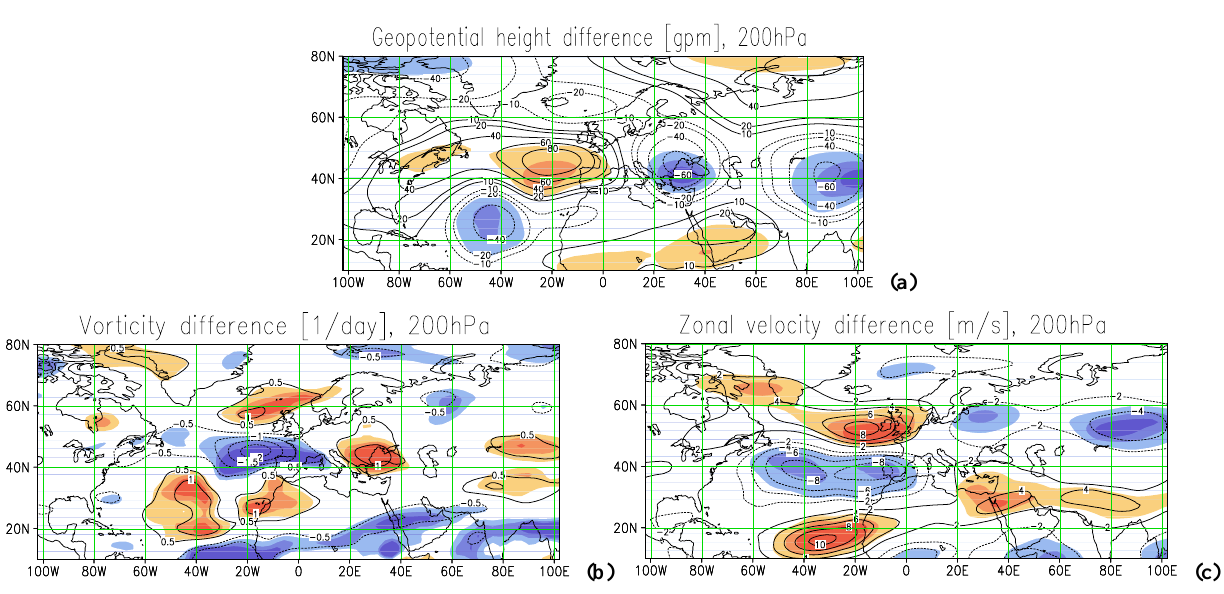
Fig. 5. Geopotential height, vorticity and zonal wind response at 200 hPa. Mean geopotential height (a) , vorticity (b) , and zonal wind (c) response at 200 hPa for the North Atlantic-European region, shading as in Fig.